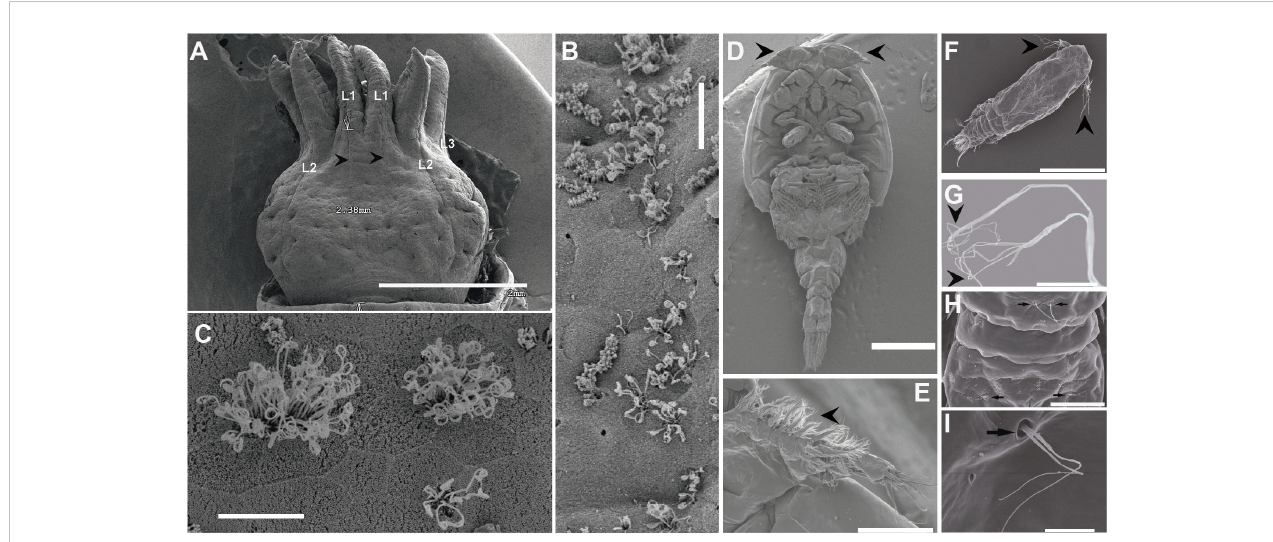
FIGURE 5 Scanning Electron Microscopy. ( A – C : Cephalopod. D – I Crustacean). (A) : Epidermal lines (lateral line analogue) on the head of Sepia of fi cinalis larva. Lateral lines on three arms and above the eye (L1 – L3) that run in anterior/posterior direction are visible. White arrows show the length of the lateral line L1 (black arrowheads). (B) : Epidermal line L1. (C) : Detail from (B) . Hair cells ’ kinocilia of L1. (D) : Ventral view of an adult whole body of sea lice (Lepeophtheirus salmonis ) showing the fi rst antenna (arrowheads) responsible from the sound perception. (E) : First antenna of an adult of L. salmonis. (F) : Dorsal view of a L. salmonis copepodid showing the fi rst antenna (arrowheads). (G) : Detail from the fi rst antenna setae showing their irregular branching tips. (H) : Dorsal view of the L. salmonis copepodid abdomen showing some paired setae (arrows). (I) : Detail from H showing the structure of a birrame setae (arrow). ( A – C : Sole ́ et al., 2022; D – I : (Sole ́ et al., 2021b). Scale bar (A, D) = 2 mm . (F) = 300 µm. (E) = 100 µm. (H) = 30 µm. (B, C, G) = 10 µm. (I) = 5 µm.